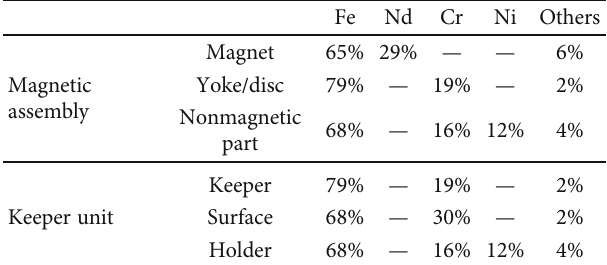
Figure 4: Buccal fl ange of maxillary denture showing magnetic attachments. Table 1: Mag fi t DX is a new thin-type, uncoated magnetic attachment with improved wear resistance. The ellipsoidal outer lip of the magnetic assembly assures fi rm fi xation to the denture base.